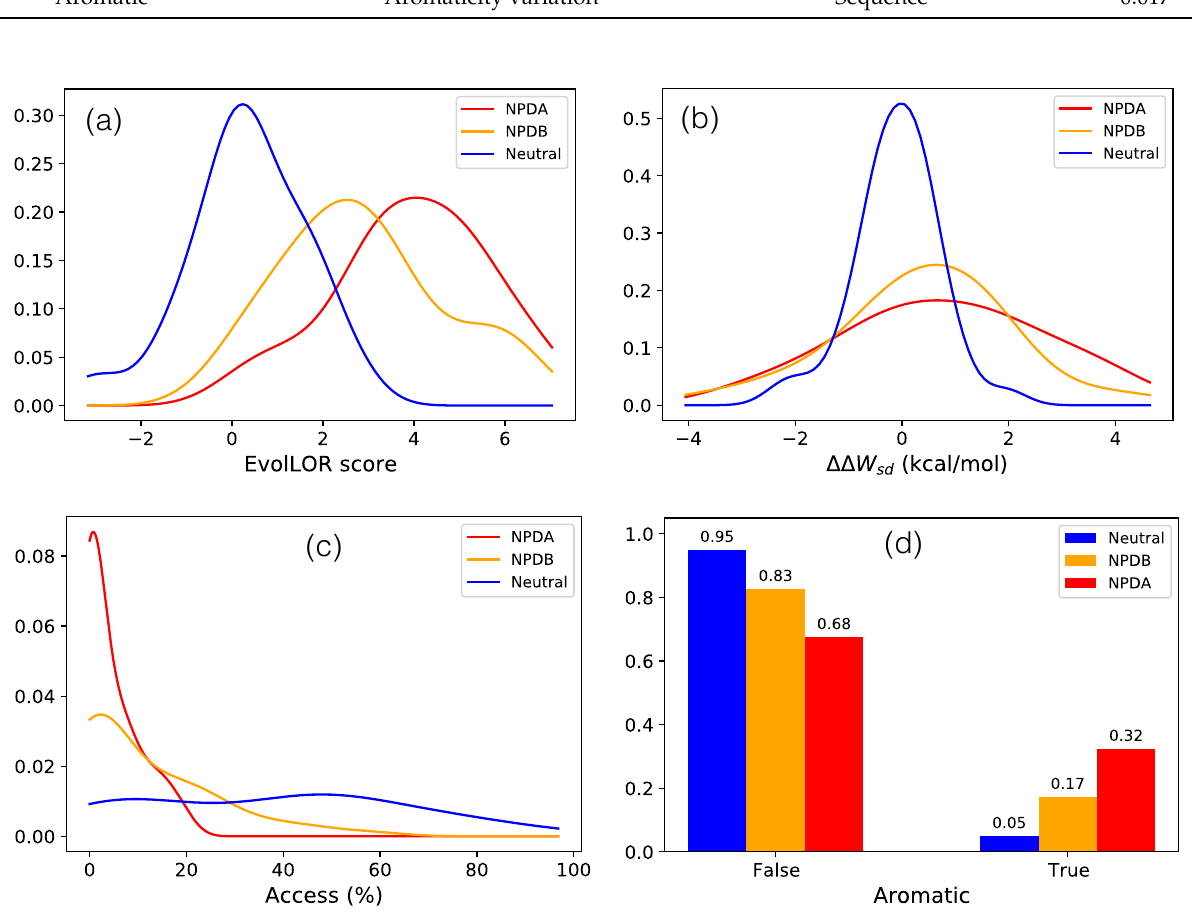
Figure 2. Probability density distributions for neutral (in blue), NPDA-associated (in red) and NPDB-associated variants (in orange). ( a ) EvolLOR evolutionary score; ( b ) ∆∆ W sd folding free energy change upon mutation; ( c ) solvent accessibility of the variant residue; ( d ) aromaticity variation upon mutation; “True” means that an aromatic residue is substituted by an non-aromatic residue or that a non-aromatic residue is substituted by an aromatic residue; “False” means that there is no change of aromaticity upon mutation. The ensemble of probability density distributions, for all tested generic predictors and features, are given in Supplementary Figure